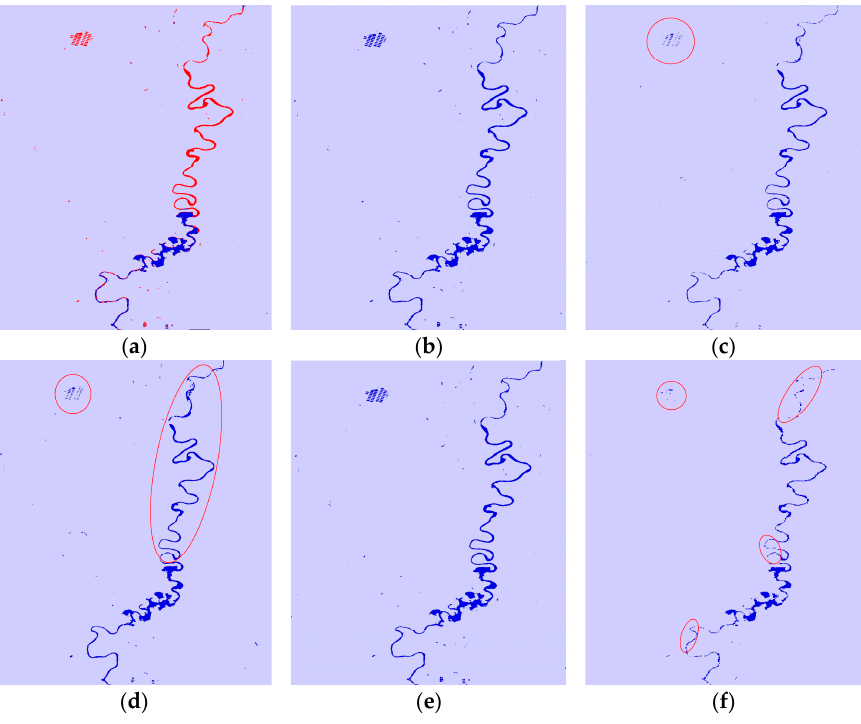
Figure 6. Water extraction results for the Yinma River Basin. ( a ) Water results extracted from optical image (with clouds). ( b ) Water results extracted from optical image (without clouds). ( c ) Water results extracted from SAR image. ( d ) Water results extracted using the MDFM (with clouds). ( e ) Water results extracted using the MDFM (without clouds). ( f ) Water extraction results of JRC-GSWE. The results show that when there is a cloud in the optical image (Figure 6a), water